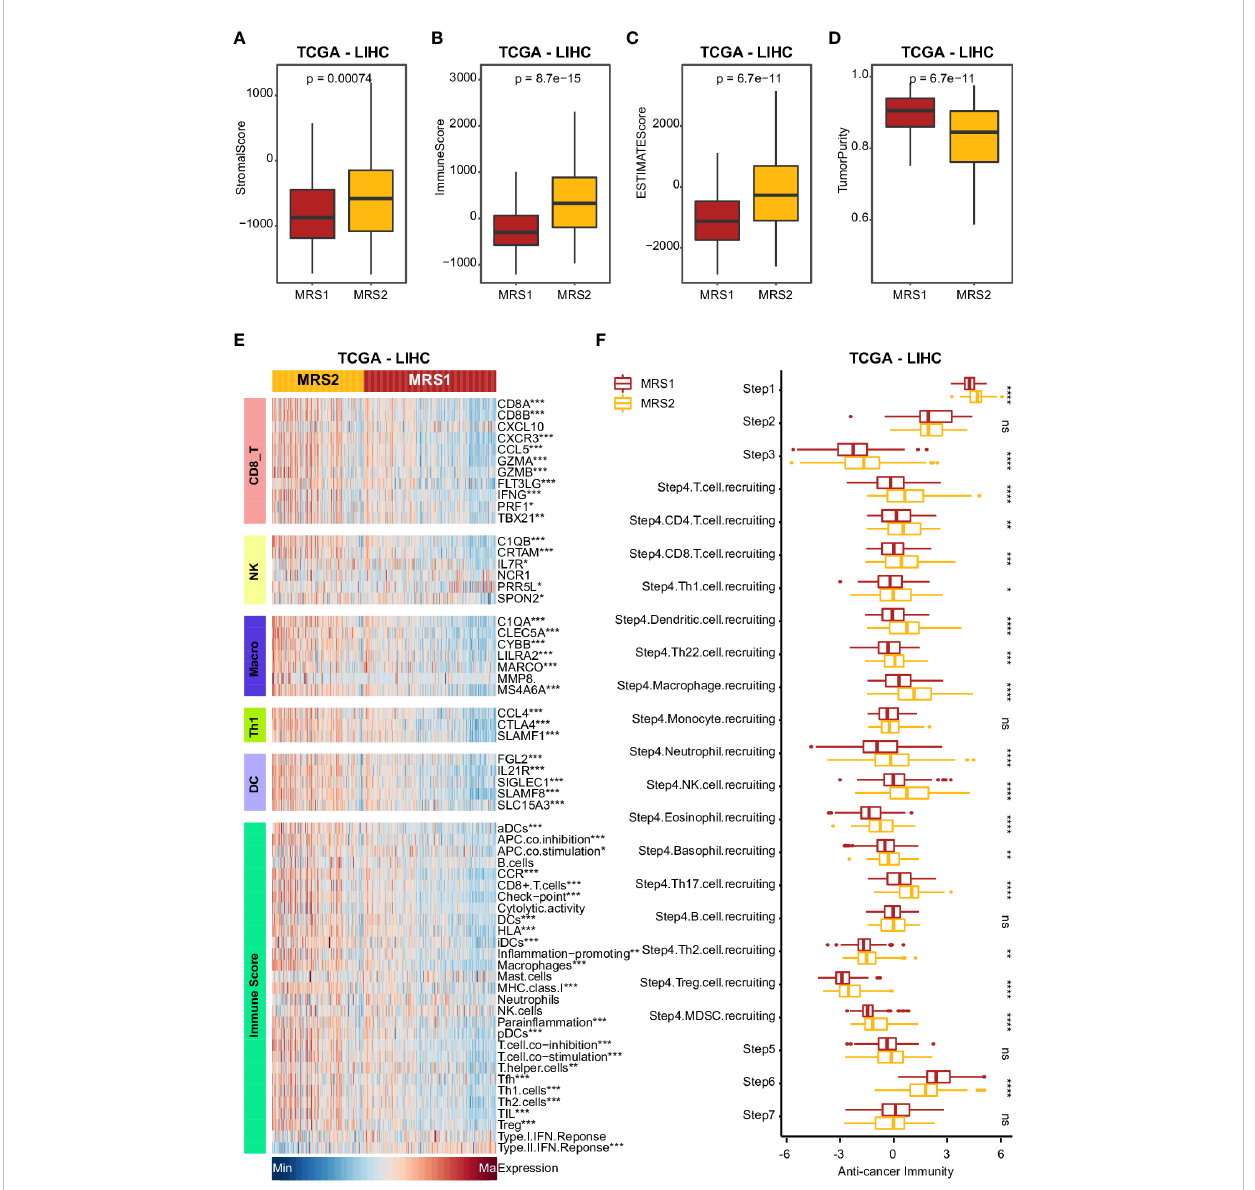
FIGURE 4 Clinical impact of immunophenotypes in the metabolic subgroups in TCGA-LIHC cohort (A-D) Boxplot showing four TME scores calculated using the ESTIMATE algorithm in two subgroups. Wilcoxon rank-sum test was used to measure the differences between two groups. Horizontal lines in the boxplots represent the median, the lower and upper hinges correspond to the fi rst and third quartiles, and the whiskers extend from the hinge up to 1.5 times the interquartile range from the hinge. (E) Heatmap comparing immune markers, immune cell in fi ltration and immune-related response in the two metabolic subgroups. (F) Boxplot showing the difference in immune responses between MRS1 and MRS2 in TCGA-LIHC cohort. *p-value < 0.05, **p-value < 0.01, ***p-value < 0.001, ****p-value < 0.0001, and ns p-value ≥